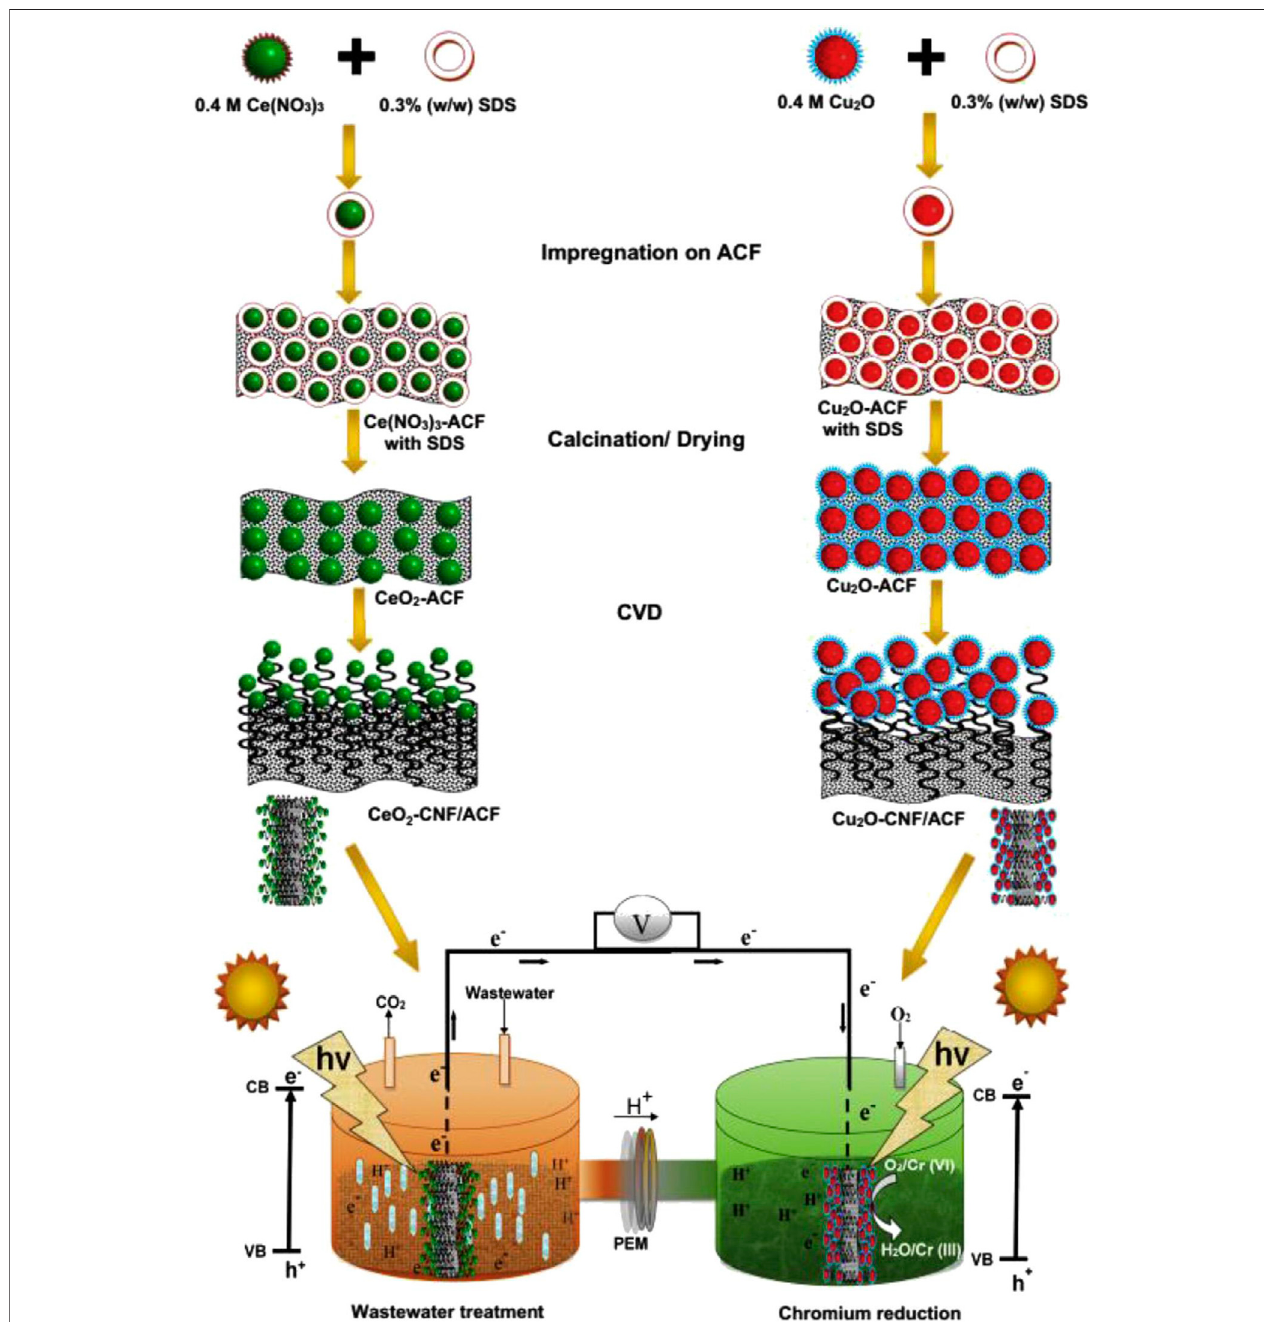
FIGURE7| Thepreparationstagesforthephotoanodeanodeandcathode,aswellastheirapplicationinMFC,areshownschematically(Pophalietal.,2021).SDS, sodium dodecyl sulfate.